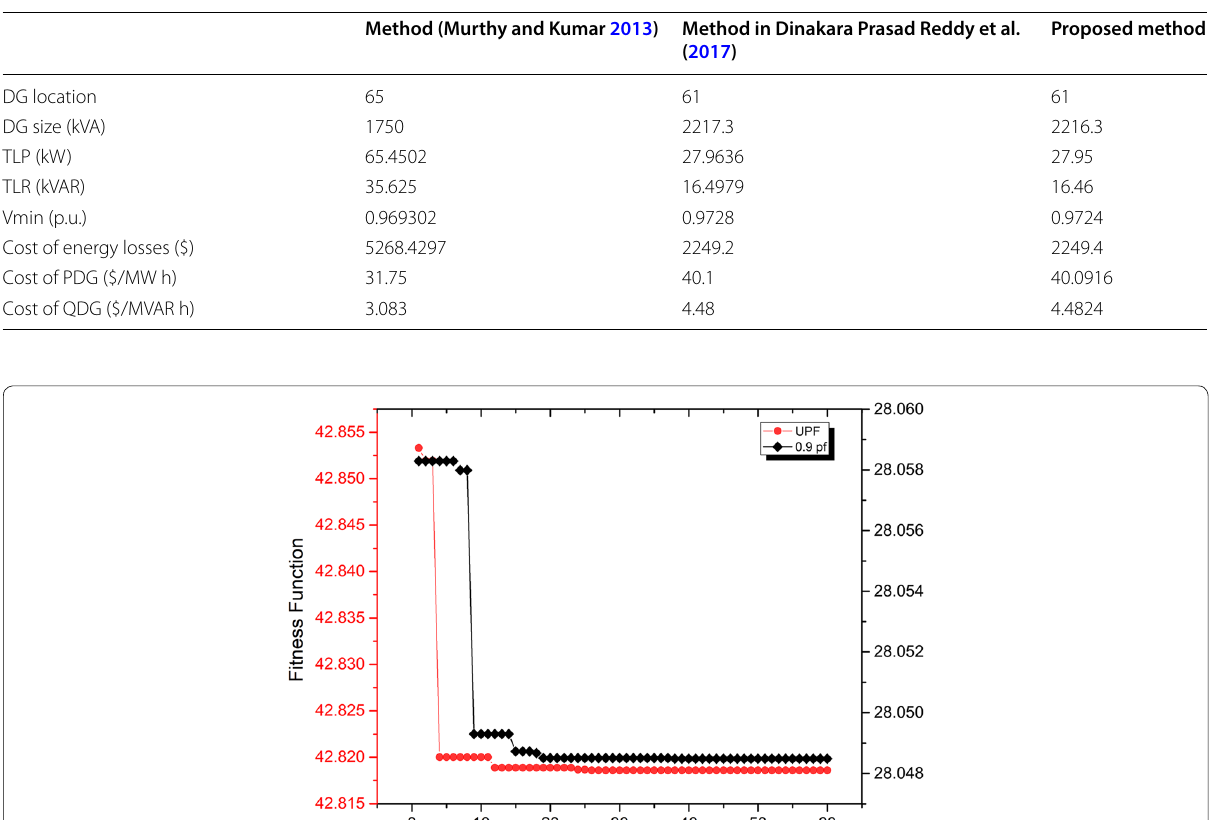
Table 8 Results for 69-bus system with DG at 0.9 pf